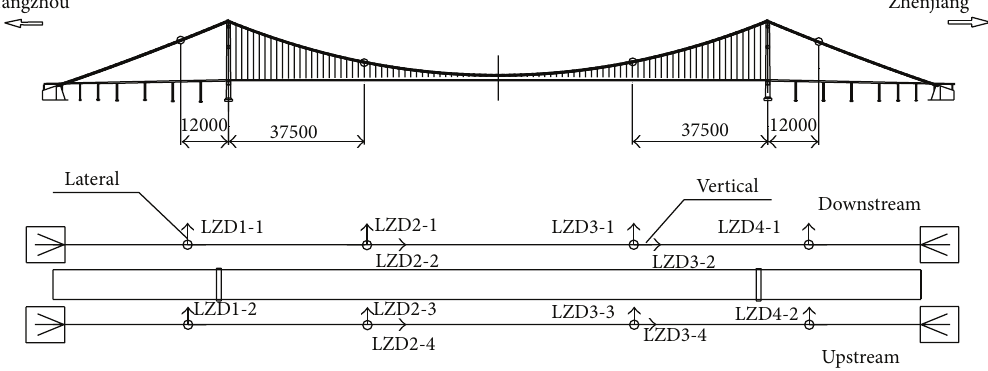
Figure 8: Layout of anemometers on the main cable of RSB.